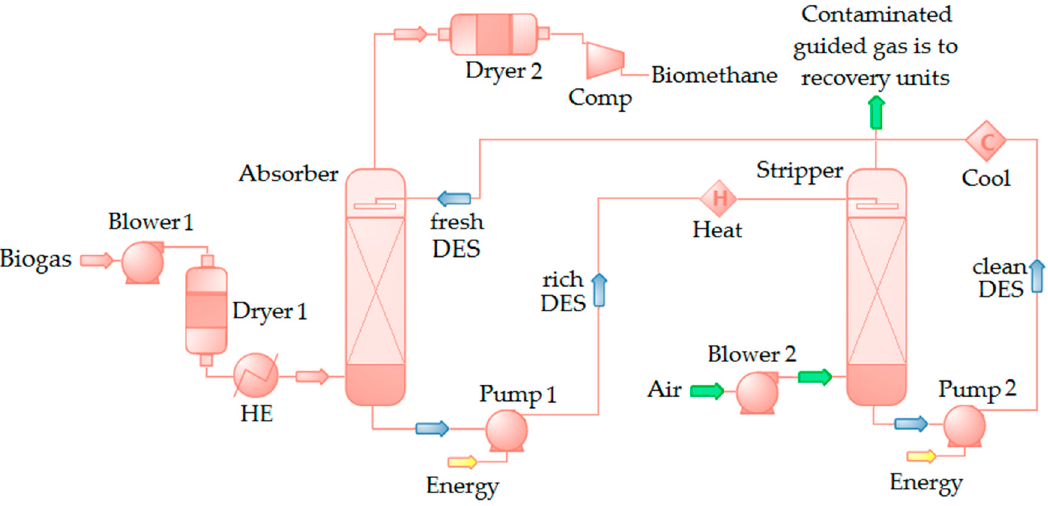
Figure 2. Scheme for the biogas upgrading technology [55,56].